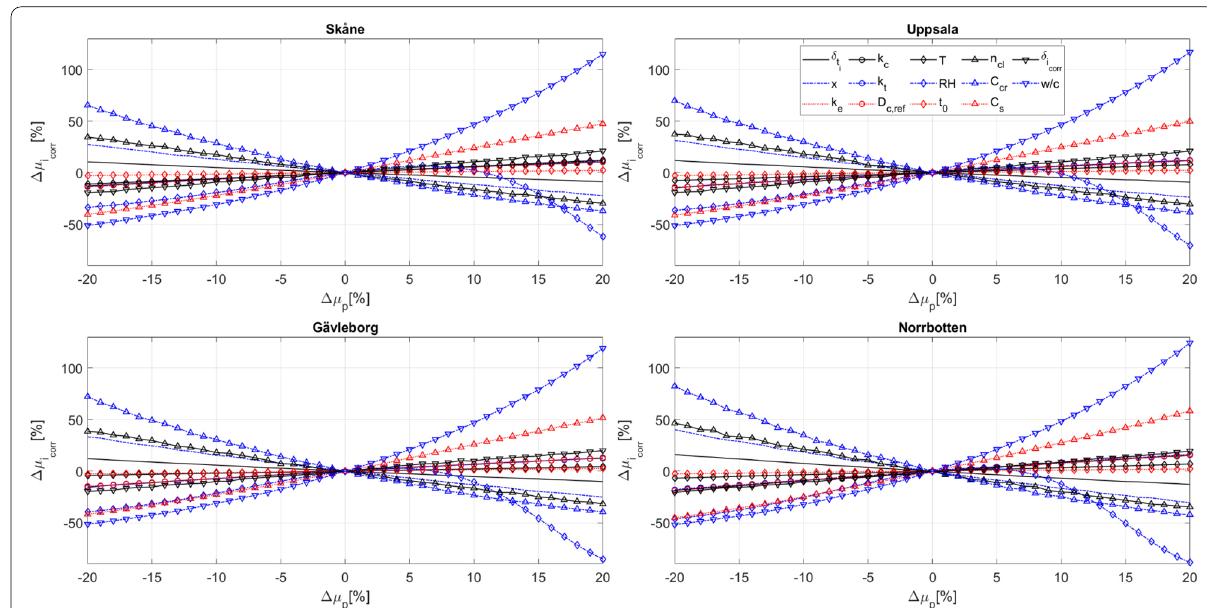
Fig. 12 Percentage change in the mean value of the end-of-century corrosion rate due to changes in the mean value of the different input parameters in the corrosion initiation and corrosion rate models considering the historical climate (1961–1990)